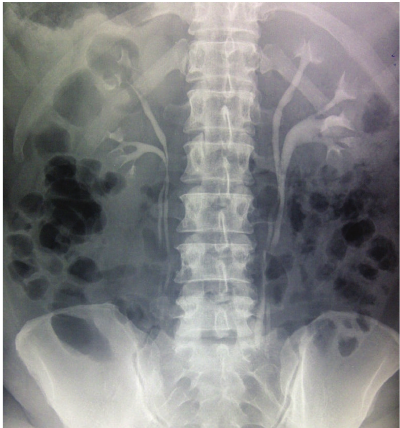
Figure 1: Intravenous urography showing the bilateral double ureters draining into the bladder.